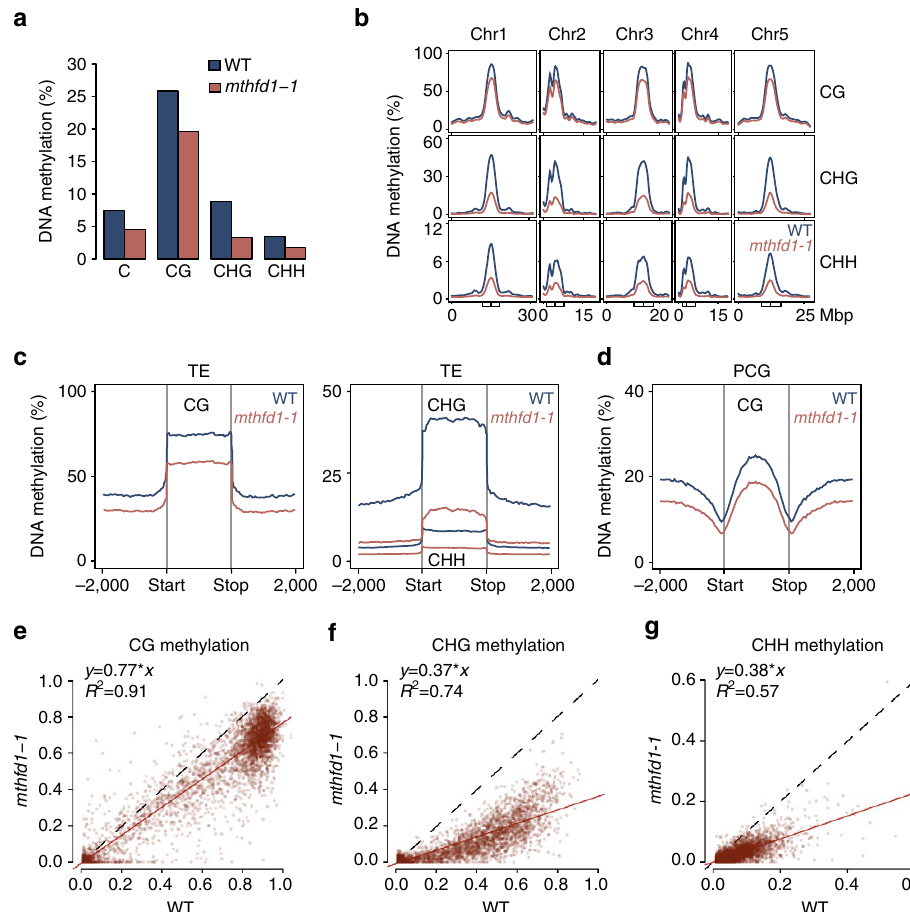
Figure 2 | DNA methylation is globally decreased in mthfd1-1 mutants. ( a ) Average genome-wide DNA methylation for all Cs and in individual sequence contexts (H ¼ C, A or T). ( b ) Chromosomal distribution of fractional DNA methylation in individual sequence contexts. Boxes and vertical lines inside boxes mark pericentromeric regions and centromeres, respectively. ( c , d ) Average distribution of DNA methylation over TEs ( c ) and PCGs ( d ) and the flanking 2,000bp in individual sequence contexts. ( e – g ) Comparison of DNA methylation levels in 5,000 random 100bp bins with WTmethylation levels 4 0.01 in CG ( e ), CHG ( f ) and CHH ( g ) contexts. Red line: linear regression between mthfd1-1 and WT levels; corresponding coefficients are shown in top left corners. Dashed: identity